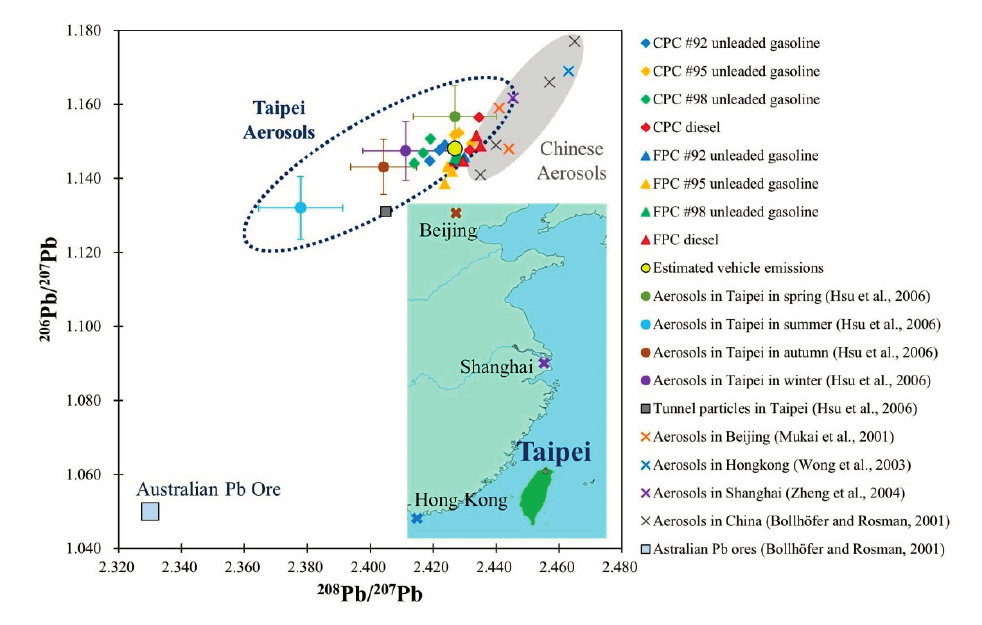
Figure 3. Scatter plot of 208 Pb/ 207 Pb versus 206 Pb/ 207 Pb for fuel products, estimated local vehicle emissions (the yellow circle), and particulate matter accumulated on wall tile surface from the main tunnels (PMT samples) [17] (the dark gray square) and seasonal aerosols collected in Taipei (drawn as the dotted ellipse; refer to Hsu et al. [17] for details data). The gray ellipse area represents Chinese aerosols [10,38,44,45]. Lead isotopic feature of Australian Pb ore [44], as the major import into Taiwan for industry, is also